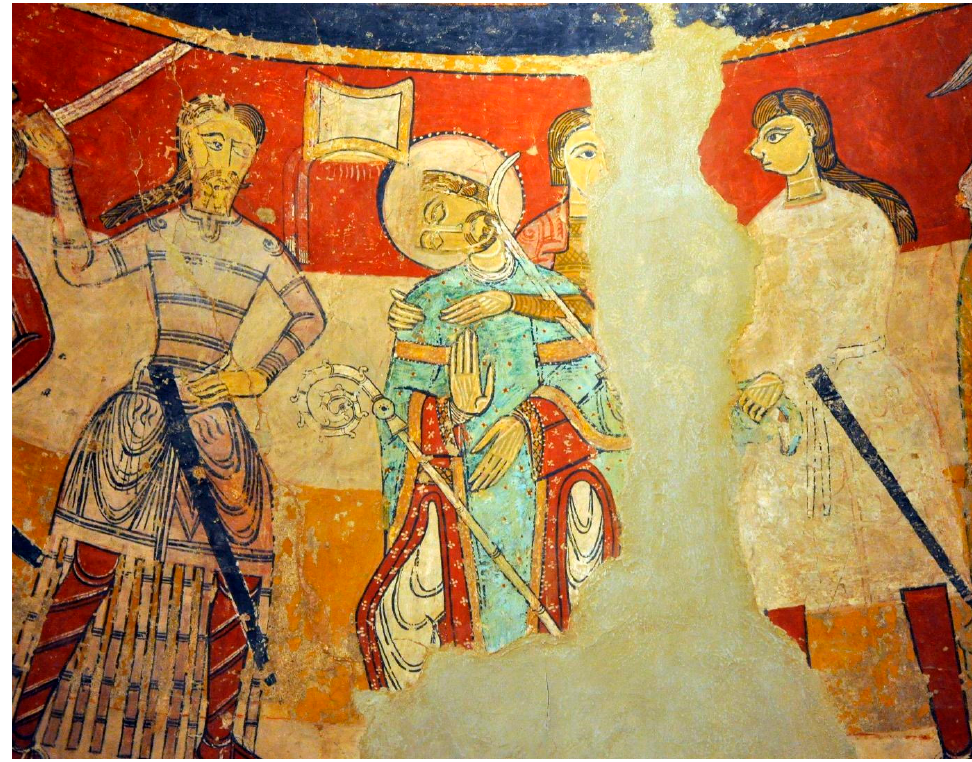
Figure 3. Wall paintings at Santa Maria de Terrassa. Detail of the central segment with the assassination of Thomas Becket . © Photo: Carles Sánchez.